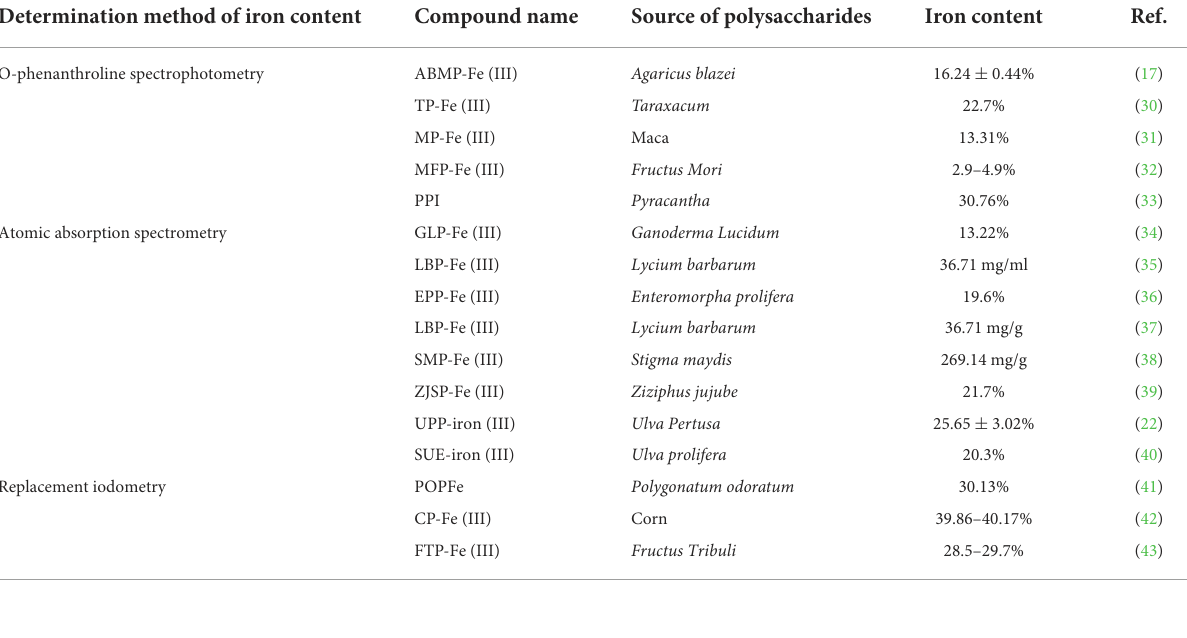
TABLE 2 Related research results of determination method of iron content in PIC.